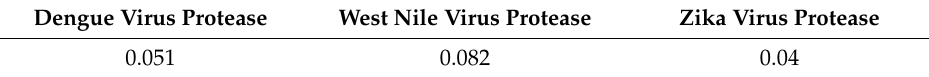
Table 7. Inhibitory activity (K i , µ M) of compound 105 in di ff erent flaviviral proteases.